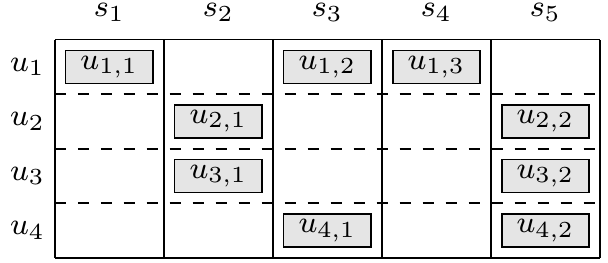
Figure 1. Example of a MAC frame with t a = 4 transmitting users and m = 5 slots. User u 1 sends three packet replicas and the other users each send two packet replicas. Slots s 1 and s 4 are singleton slots and the left s 2 , s 3 , and s 5 are collision slots.